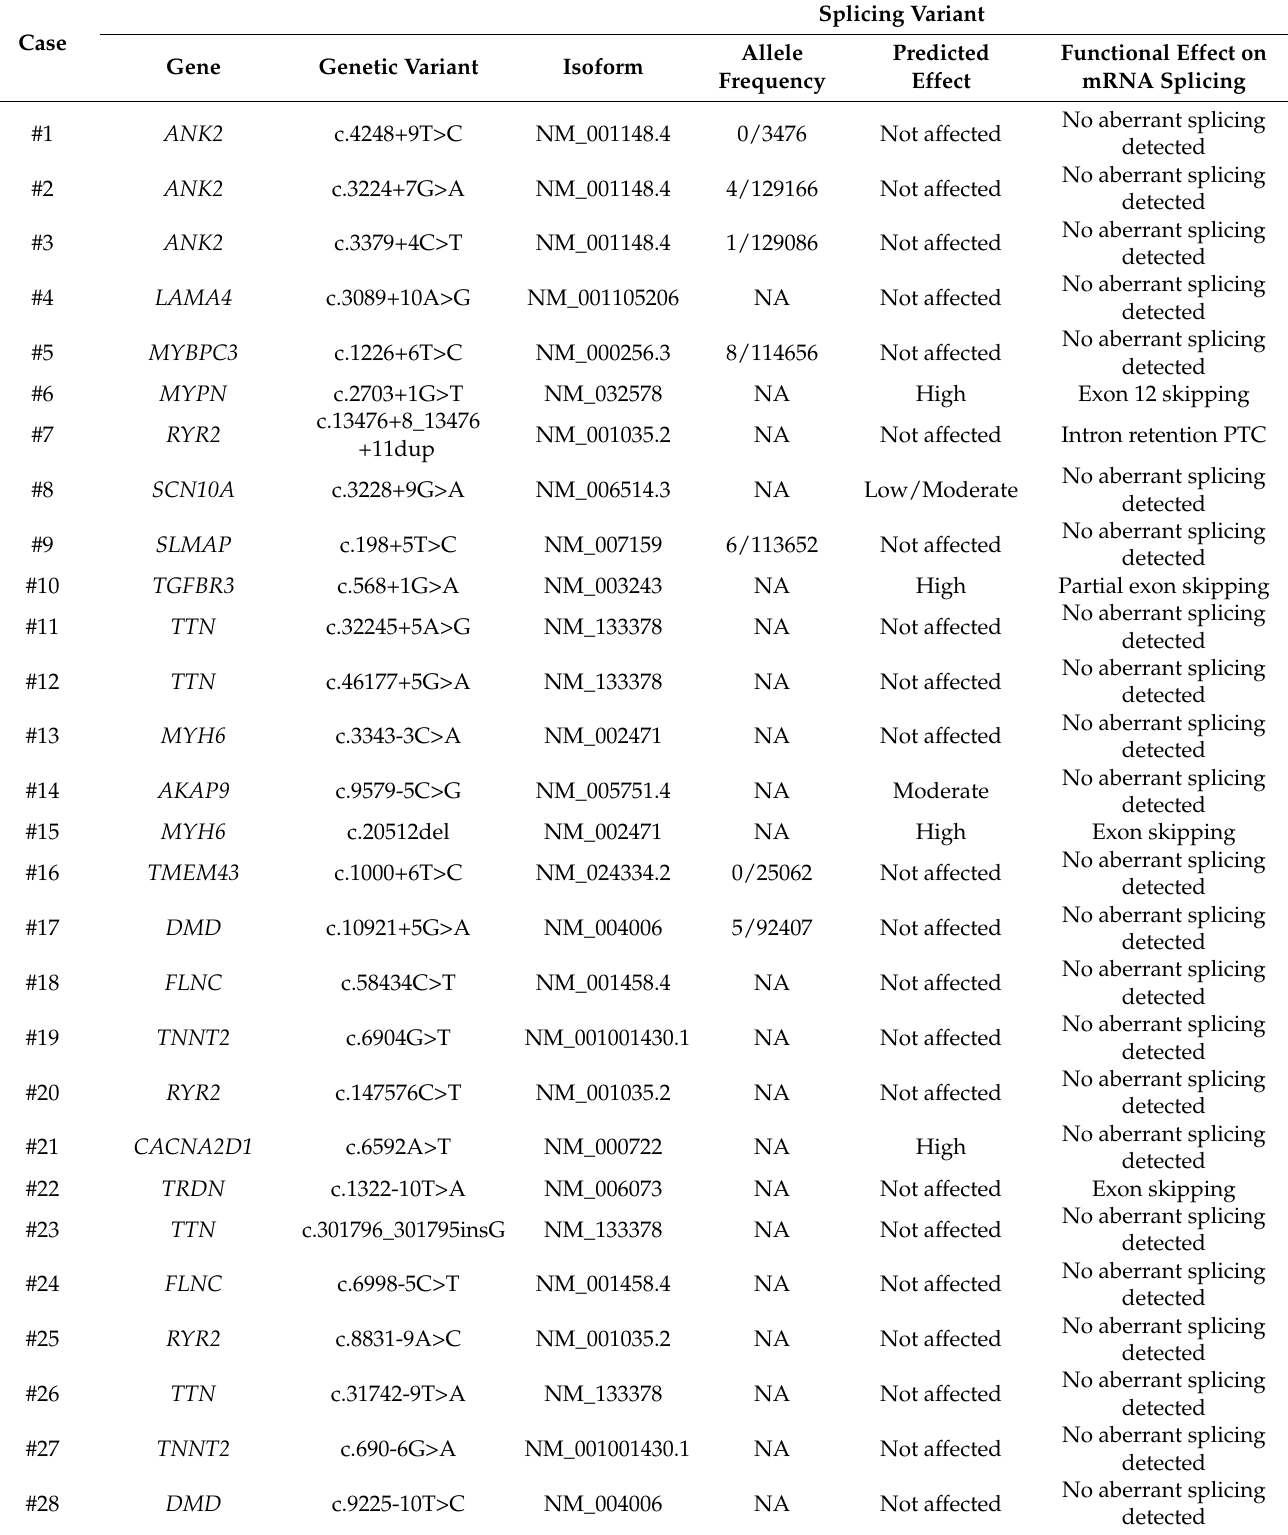
Table 2. In silico prediction and experimental effect of variants. Allele frequency obtained from the gnomAD database (allele count/allele number of European population). NA = not